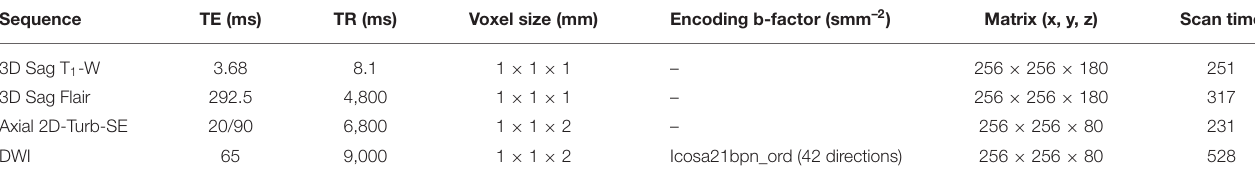
TABLE 3 | Imaging